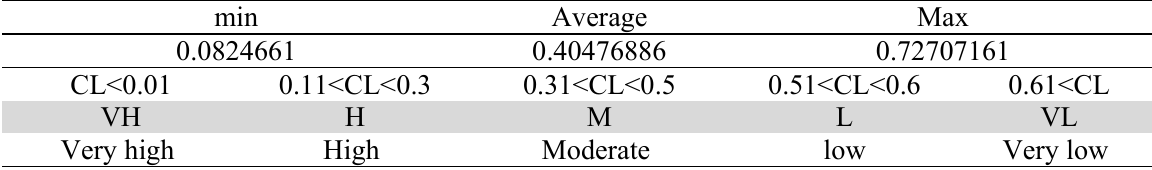
Max, min, and mean for real